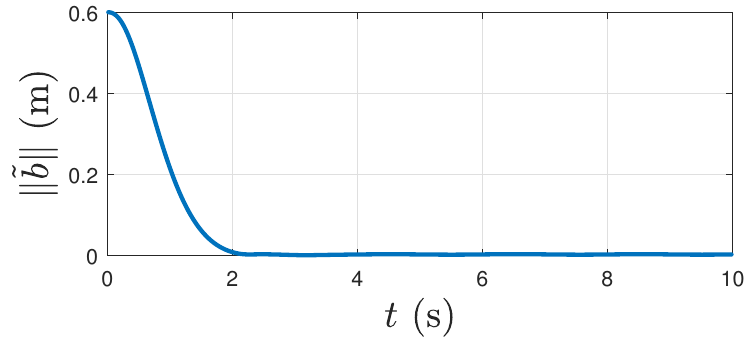
Figure 4. Magnitude of position error versus time.